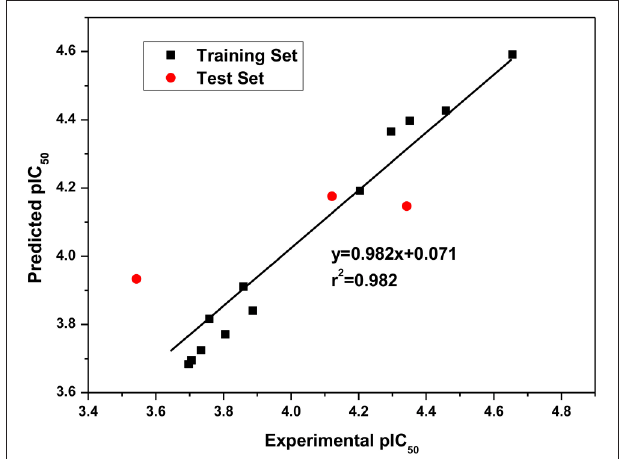
FIGURE 5 | Experimental versus predicted HepG2 inhibitory activities of the training set and the test set. The well agreement between predicted pIC 50 -value and experimental pIC 50 -value for both test sets and training sets indicated that this model was reliable in forecasting activity for the listed